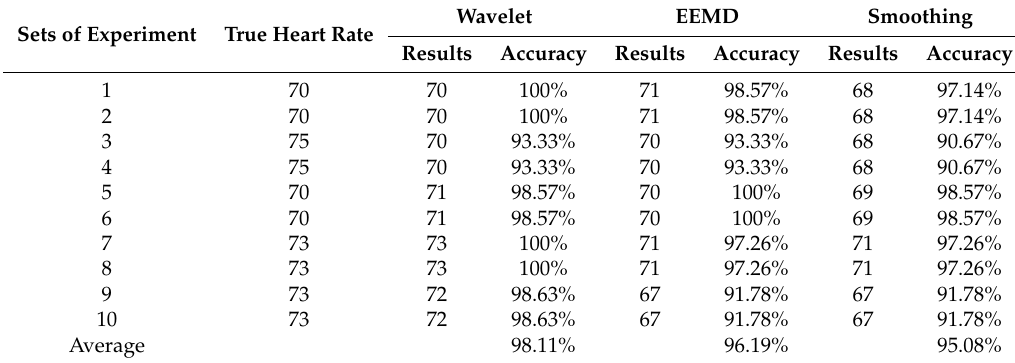
Table 4. The results of the heart-rate test with the time period of 60 s.